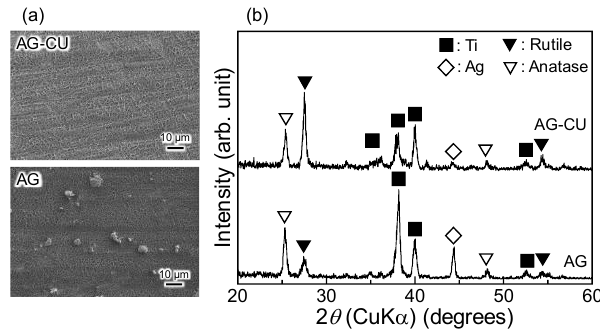
Figure 1. ( a ) SEM images and ( b ) TF-XRD patterns of samples. AG-CU contained Ag at 2.5 at.% and Cu at 4.9 at.% on its surface, and AG contained Ag at 6.3 at.% on its surface (Table 1). AG-CU contained almost twice as much Cu as Ag. The amount of Ag in AG was higher than that in AG-CU, which can be attributed to the higher concentration of Ag in the silver nitrate (AgNO 3 ) solution used for the treatment ∼ = ∼ = of AG ( 1 mM) compared to that ( 0.5 mM) used for the treatment of AG-CU. Although the concentrations of Ag and Cu in the AgNO 3 -Cu(NO 3 ) 2 mixed solution used for the ∼ = treatment of AG-CU were the same ( 0.5 mM), AG-CU contained almost twice as much Cu as Ag on its surface. These results indicate that Ag and Cu can be co-doped into a sample by using an AgNO 3 -Cu(NO 3 ) 2 mixed solution, but the amount of Ag doped into the sample will not be simply proportional to the Ag concentration of the Ag- and Cu-containing solution used for